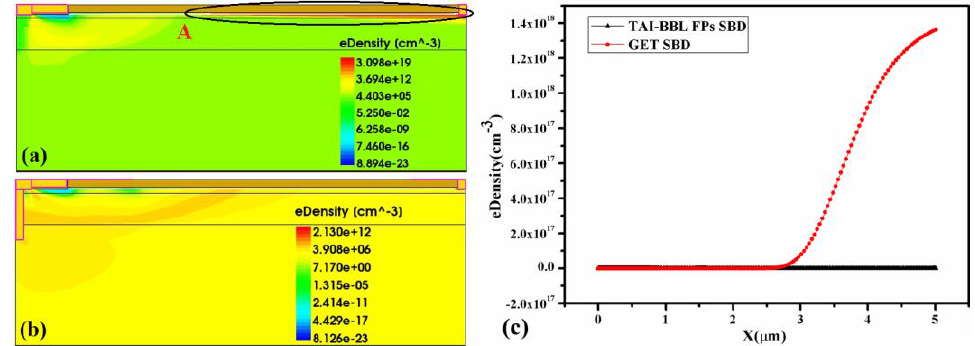
Figure 5. The electron concentration distribution of: ( a ) GET SBD, ( b ) the TAI-BBL FP SBD when the breakdown occurs, ( c ) the corresponding curve distribution.